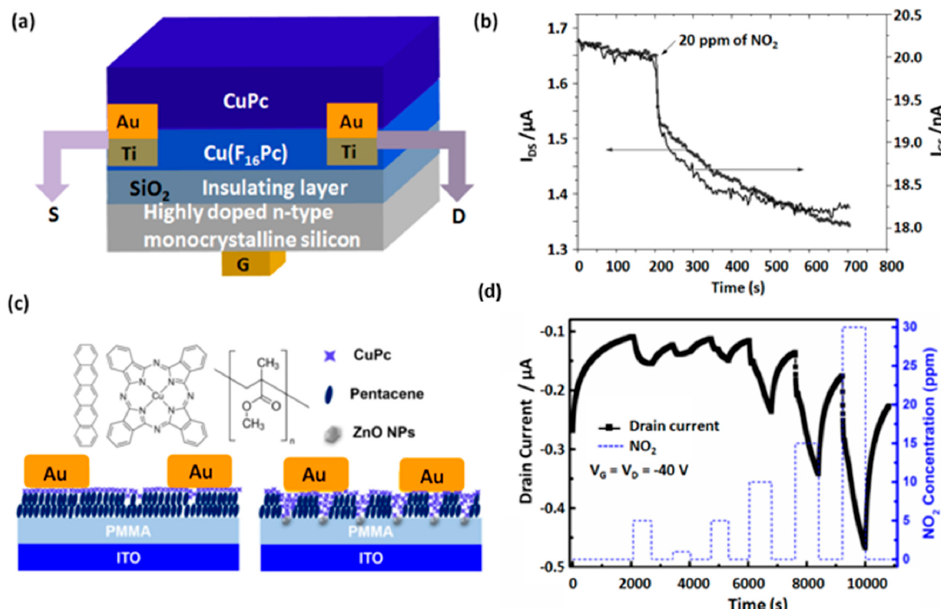
Figure 8. Scheme of OFET design having a suspended gate, Si substrate, SiO 2 dielectric, Au-Pt as source and drain electrodes and the Cu(F 16 Pc) / CuPc bilayer ( a ) and change in drain and fate current under 20 ppm of NO 2 exposure ( b ) (adapted from [66]). Scheme of OFET device design, molecular structure of constituents and the microstructure of CuPc / Pentacene heterostructure with ZnO / PMMA dielectric layer on a ITO substrate ( c ). Variations in drain current with 10 min exposure to NO 2 (in a concentration range of 0.5–15 ppm) and 10 min recovery in dry air ( d ) (adapted from [67]).